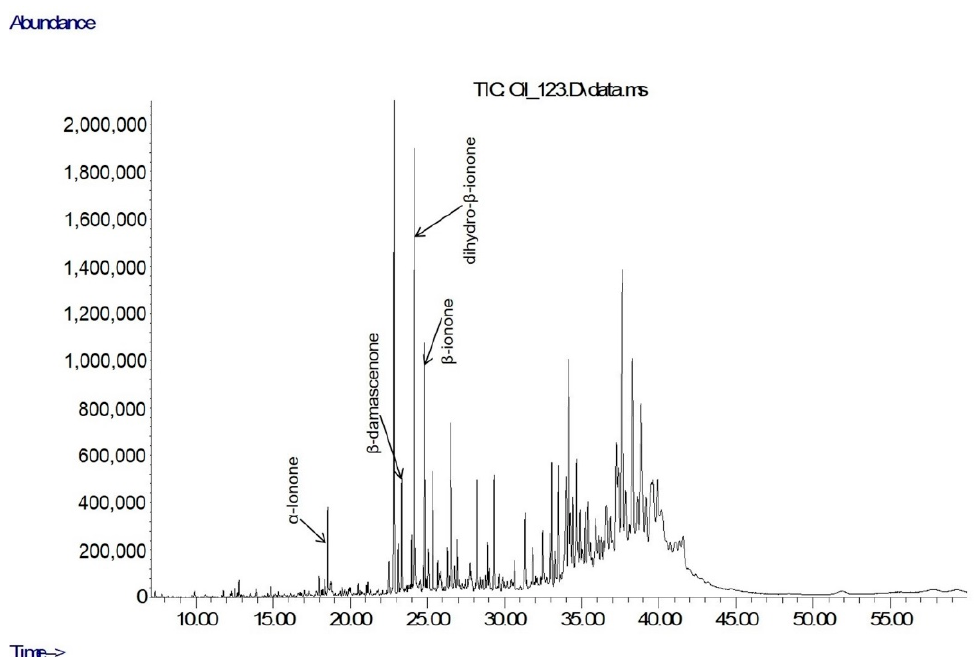
Figure 2. Example of a TIC chromatogram of tobacco EO (OR(Kr)).